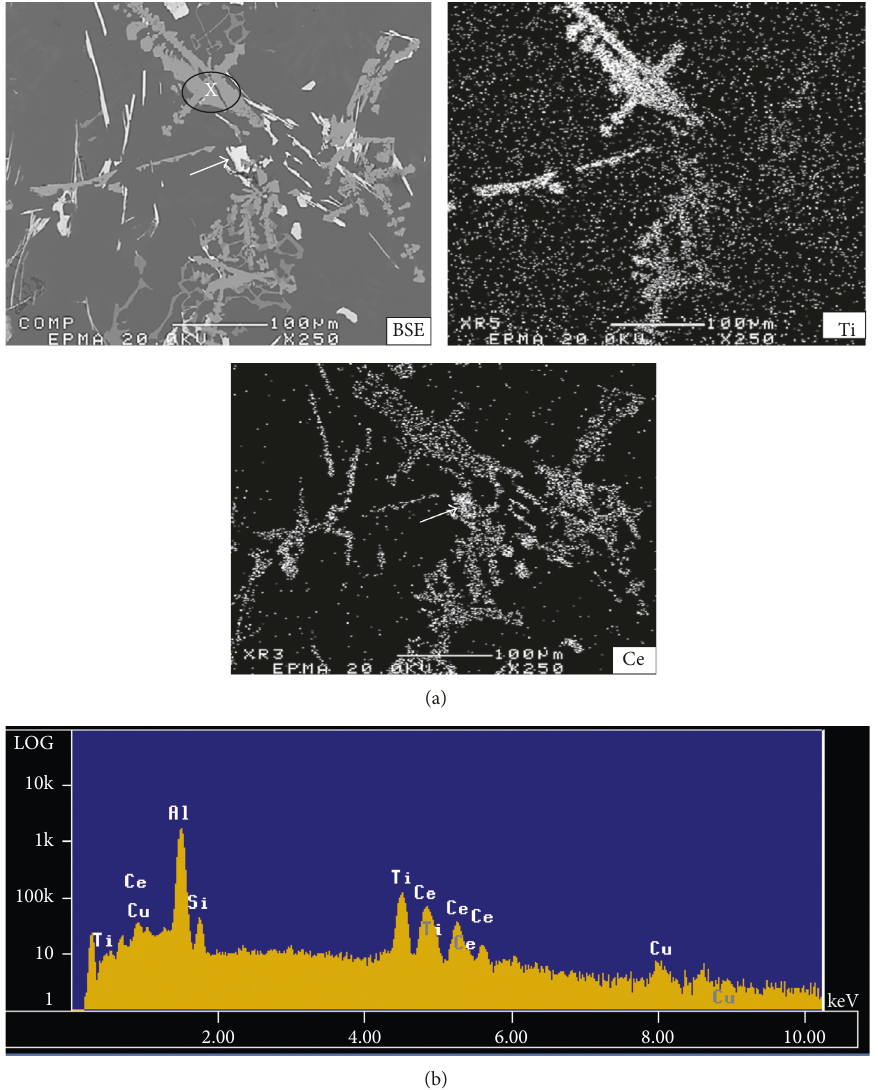
Figure 10: (a) Backscattered electron image and distribution of Ti and Ce in D0 +Ce +Ti alloy and (b) EDS spectrum corresponding to the gray phase marked X in (a). White arrows indicate high Ce concentration in the white-phase